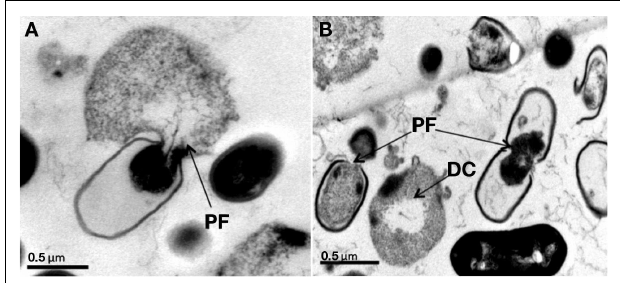
FIGURE 2 | (A,B) TEM micrographs showing Listeria monocytogenes LMA-1045 after 1min of contact with solvent extracts of Wickerhamomyces anomalus LMA-827 (A) and Candida tropicalis LMA-693 (B) culture supernatants. PF – pore formation in cell membrane; DC – digested cell. Grids were examined at 80kV.The magnification factor is 30,000 × . Bars indicate 0.5 µ